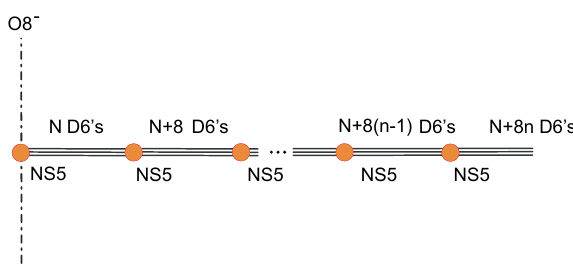
Figure 33 . Type IIA brane con(cid:12)guration for the 6d linear quiver theory (4.22).